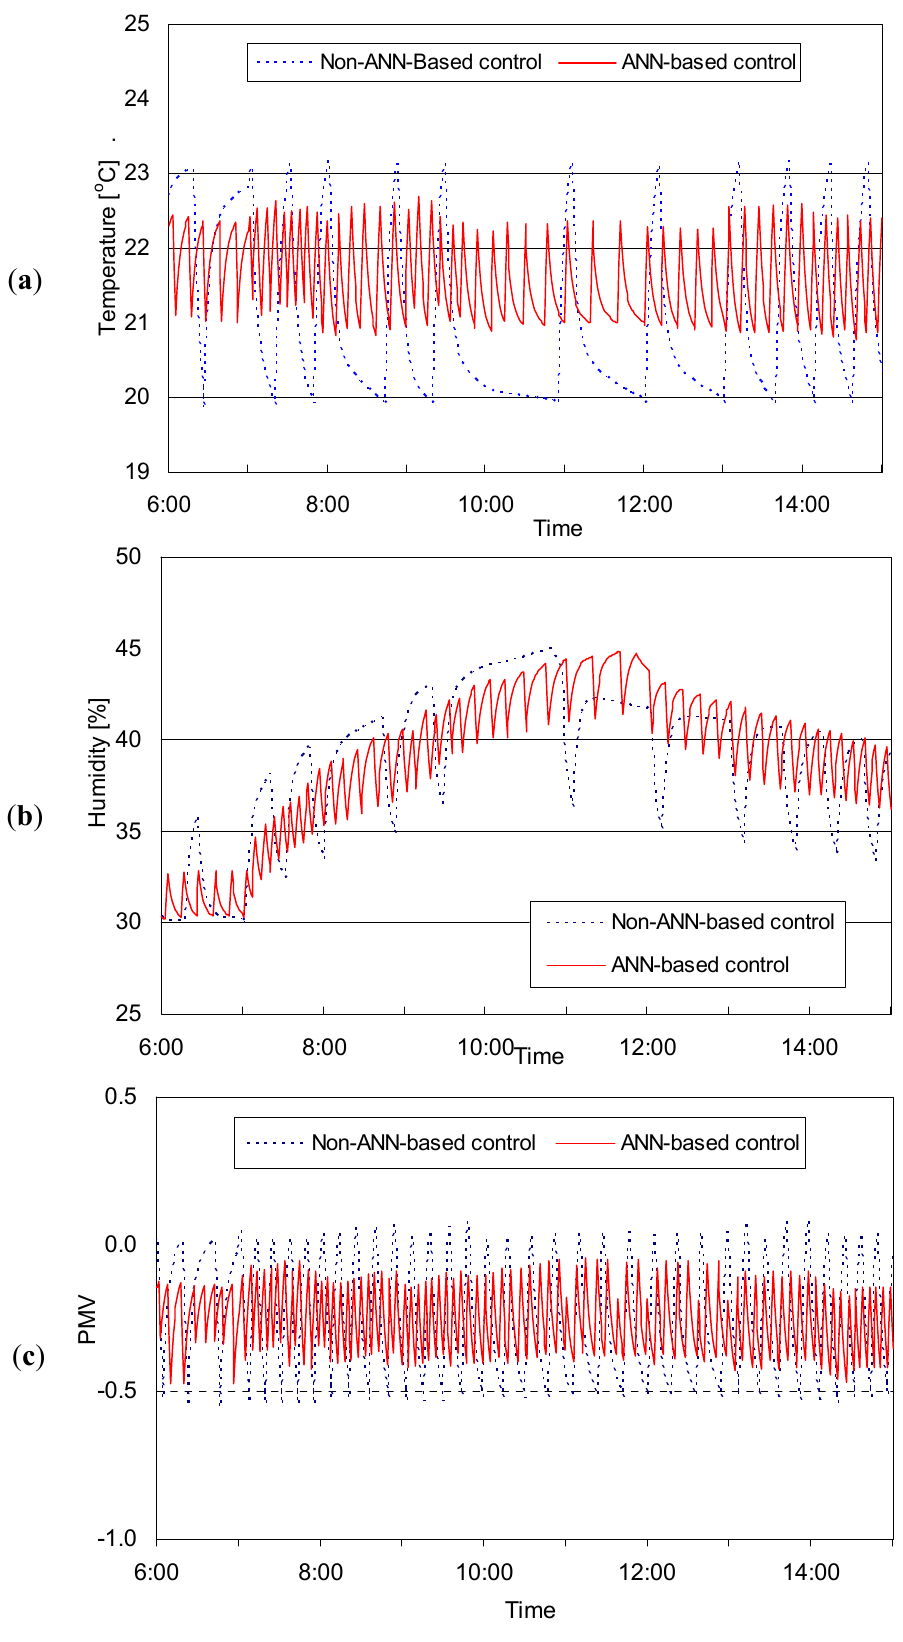
Figure 8. Comparative profiles of thermal factors of non-ANN and ANN-based logics in winter (Base case 6:00–15:00 on January 30, 2007). ( a ) Temperature control logic; ( b ) Humidity control logic; ( c ) PMV control